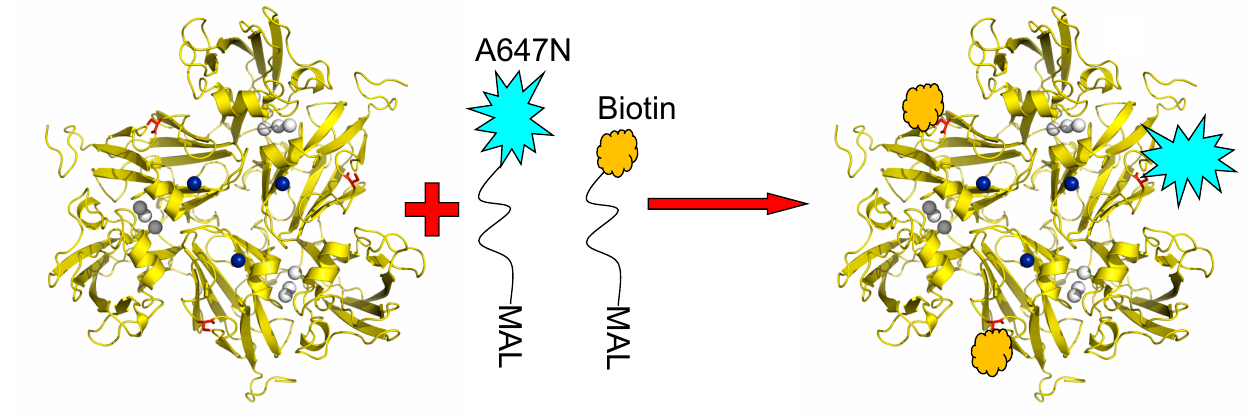
Figure 8. K204C variant of SLAC conjugated with Atto647N-maleimide and biotin-peg-maleimide. The conditions are chosen so that the labeling ratio of the dye to protein doesn’t exceed 5% to ensure most enzyme molecules carry only one or no fluorescent label. T1 Cu is depicted in blue, TNC in grey and Cys204 in red. Reprinted with permission from [43]. Copyright 2014 The Americal Chemical Society.